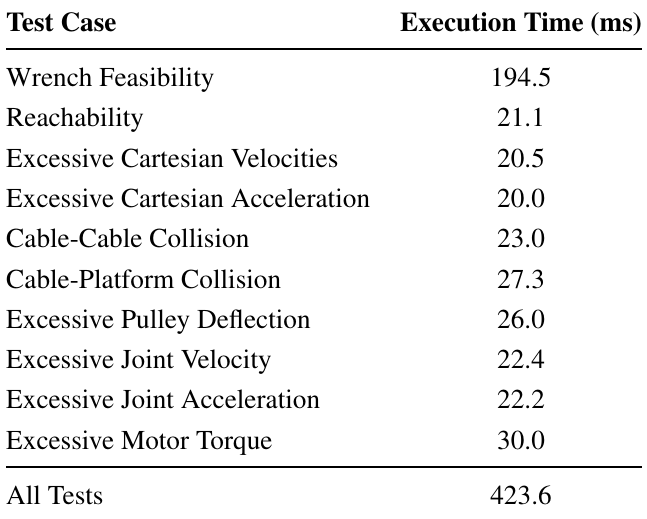
Table 1. Benchmarking results of the developed tests run over the full trajectory presented in this